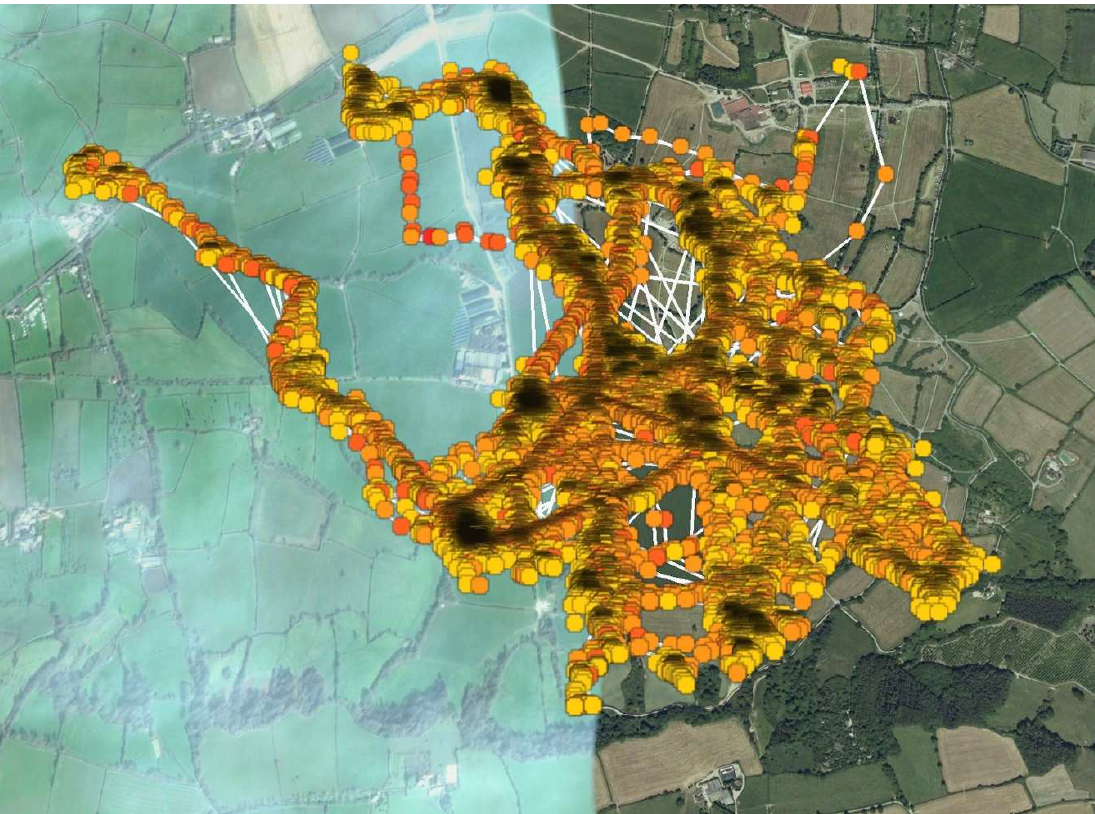
Figure 1. Location of physical activity intensities for all participants around the festival site. Circle colour indication: Yellow = Light; Orange = Moderate; Red = Vigorous. (Dark areas indicate increased density of physical activity; white lines represent additional movement pathways with minimal physical activity registered).